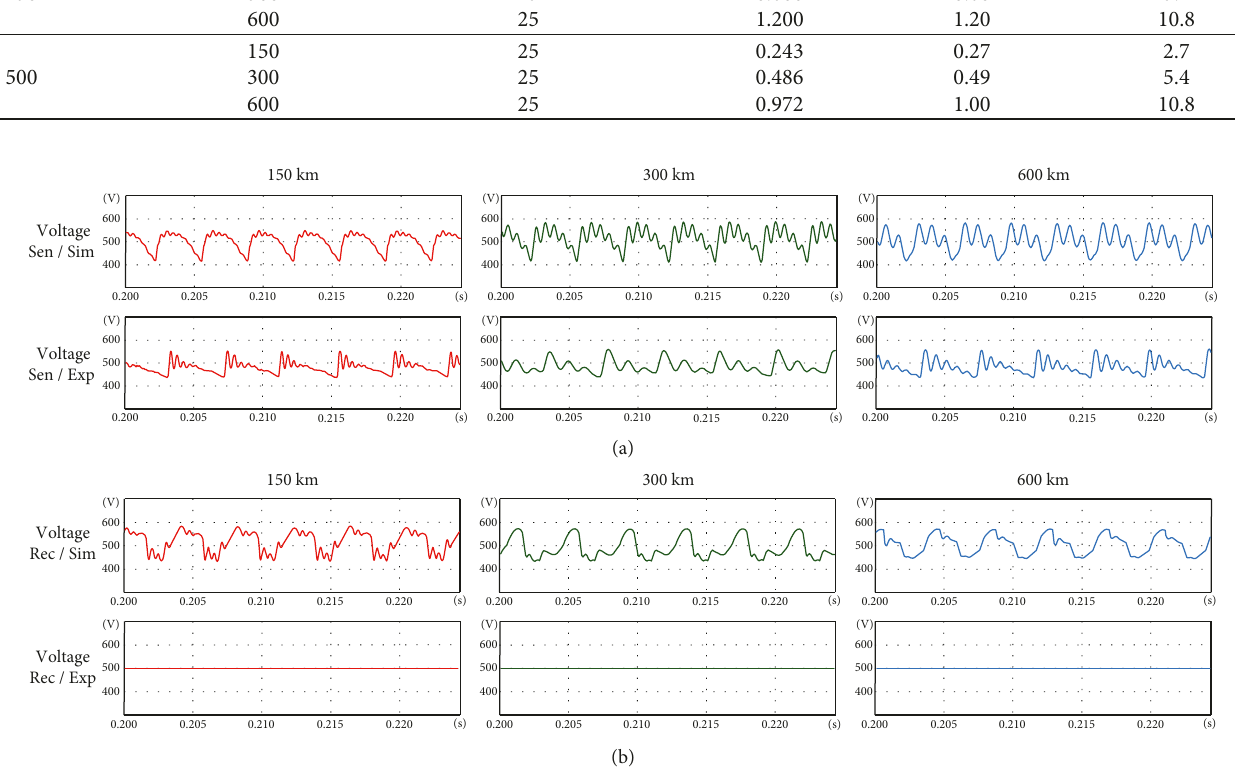
Figure 12: Comparison of the voltage waveforms based on the transmission line distance conditions. (a) Comparison of the sending side voltage waveforms and (b) comparison of the receiving side voltage waveforms.